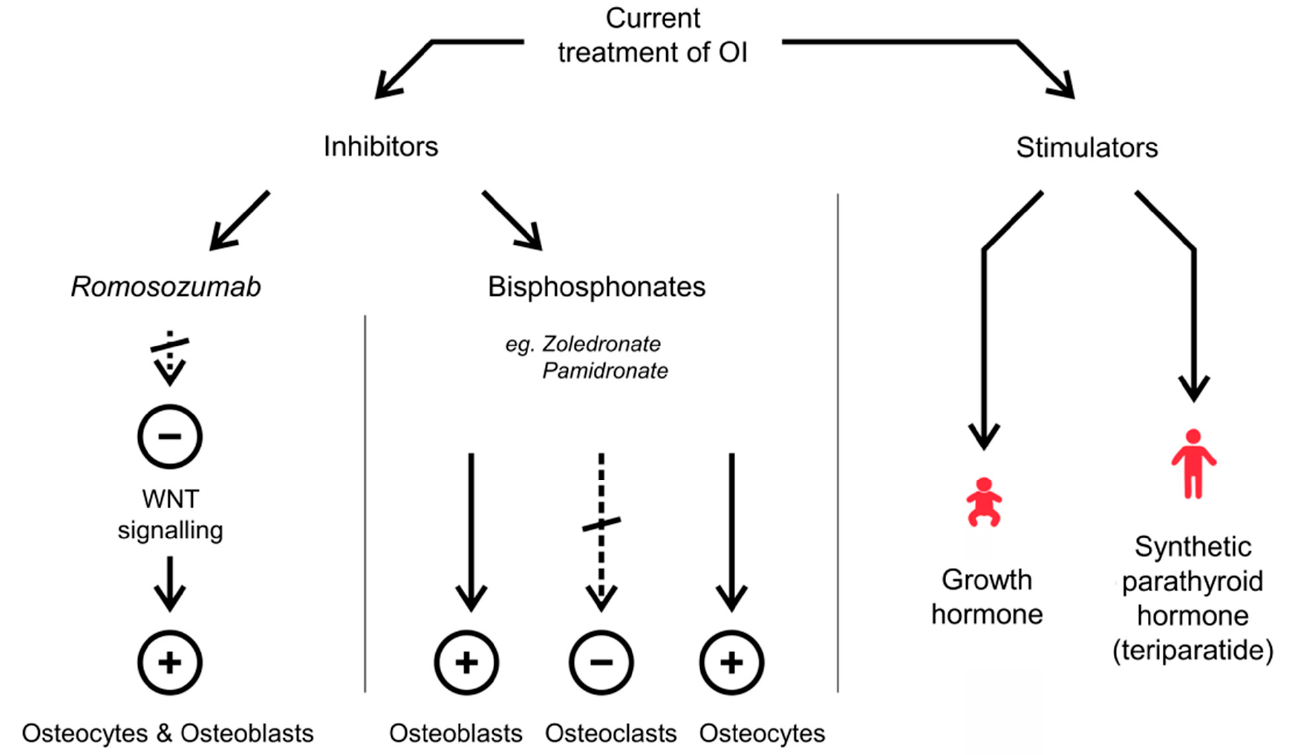
Figure 1. Schematic overview of currently used medications to treat OI. The use of some inhibitors allows for increased bone mass by inhibiting the osteoclast cycle while inducing osteoblasts and osteocytes, e.g., Zoledronate and Pamidronate , the most commonly used BPs with high affinity for hydroxyapatite crystals. In contrast, Romosozumab, which exerts its effect by inhibiting the Wingless-type MMTV integration site family, member 1 (WNT) signalling involved in osteocytes–osteoblasts stimulation, and stimulators, such as growth hormone and teriparatide, induce bone formation instead of inhibiting osteoclast function. Drug names are indicated in italics.